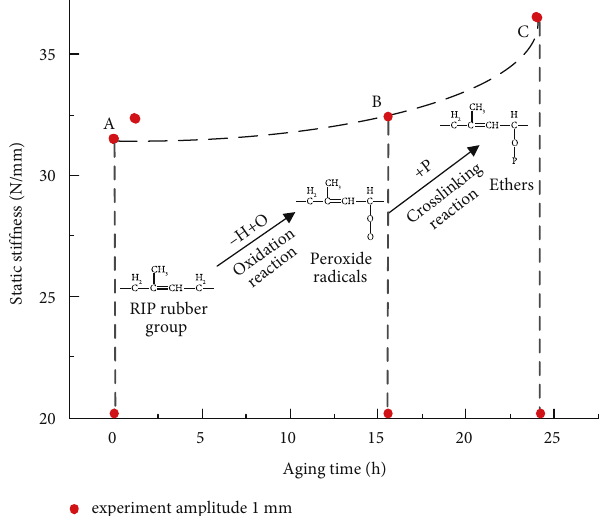
Figure 19: The changes in the internal molecular structure and the static sti ff